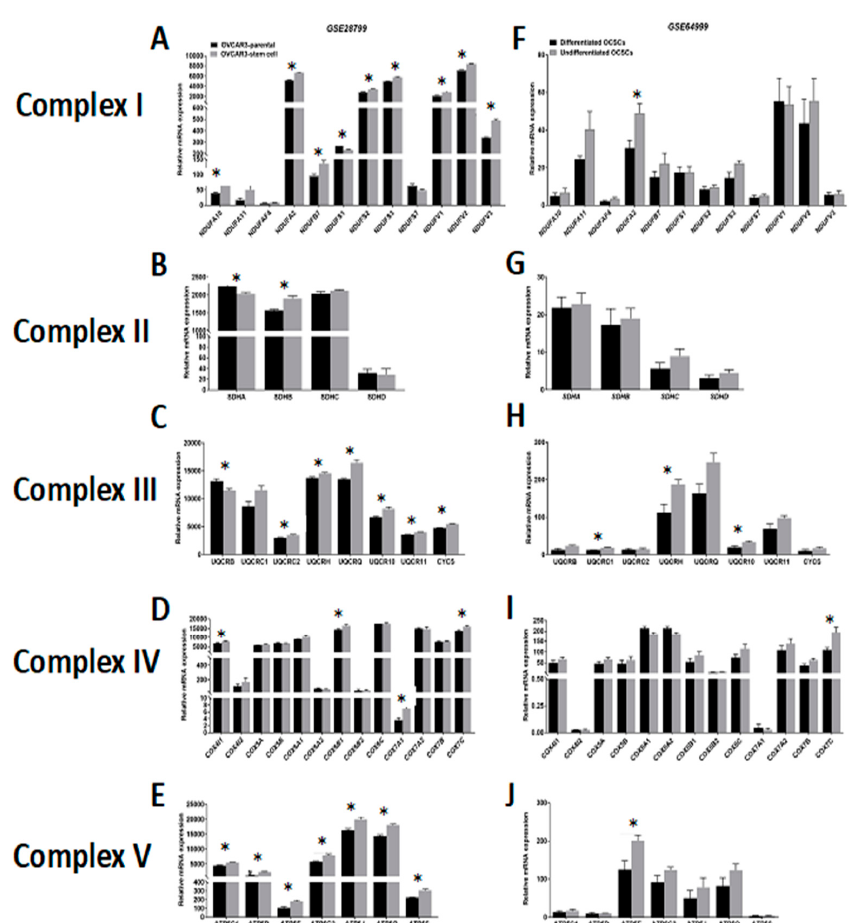
Figure 5. Expression of electron transport chain (ETC) complexes in GSE28799 and GSE64999.